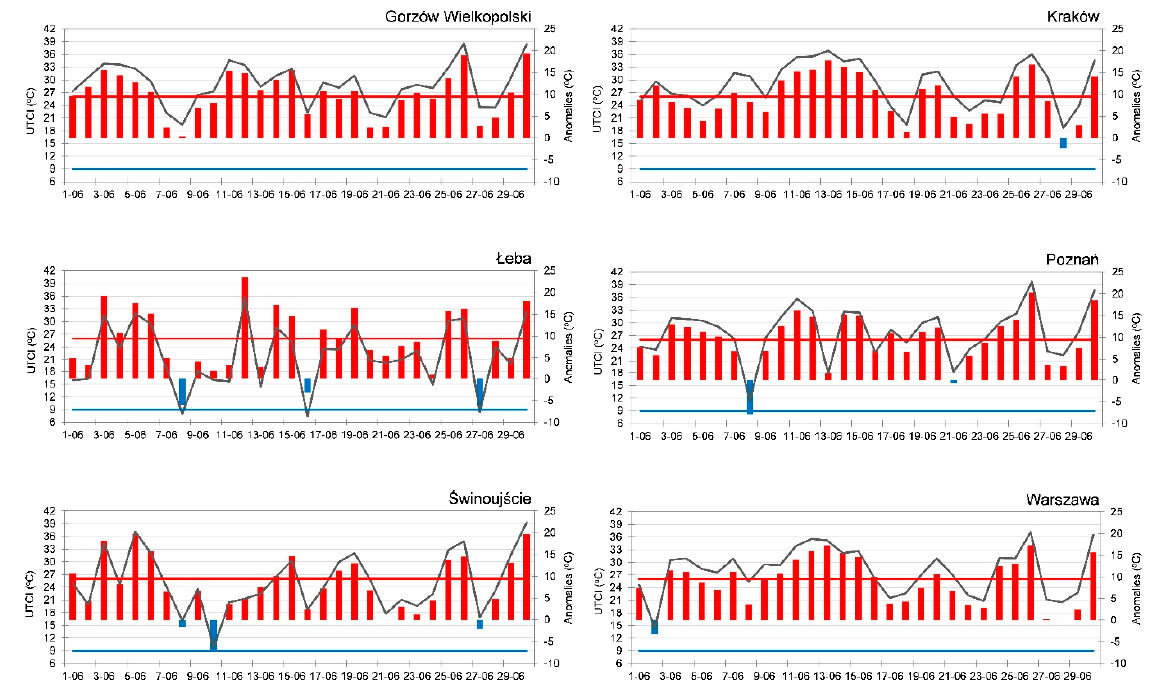
Figure 8. Monthly course of UTCI in June 2019 (line) with anomalies (column). The red line is the heat stress threshold, the blue line is the cold stress threshold.